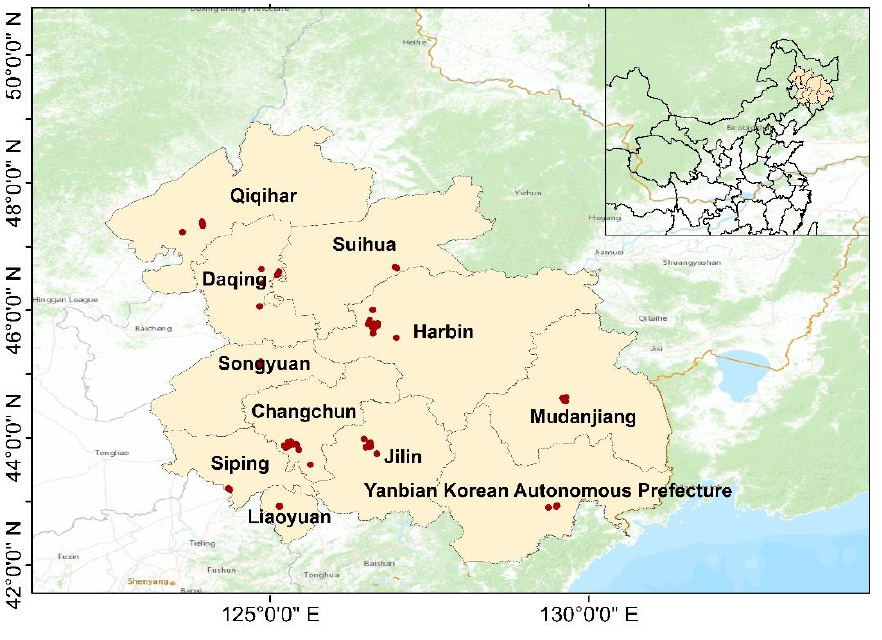
Figure 1. Air quality monitoring stations in HCUA.